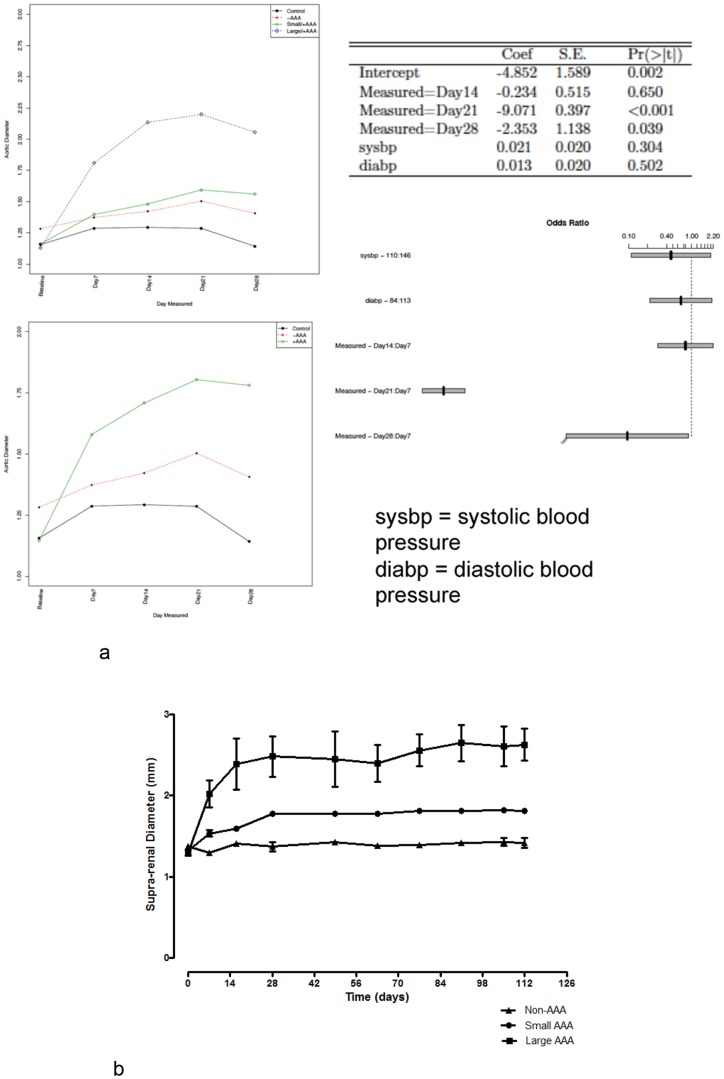
Pattern of AAA development(A) Consistent Temporal Pattern of AAA Development. Temporal evolution of AAA demonstrating the earlier occurrence of large aneurysms in contradistinction to the later development of small aneurysms in mice that underwent continuous 4-week infusion of Ang II (n = 85). The size phenotype appears to be defined at the outset of AAA development, thus suggesting differential susceptibility to Ang II-induced AAA development in genetically homogenous mice. (B): No Quantitative AAA regression Following Cessation of Angiotensin. Continued in vivo US surveillance of a subgroup of mice (n = 10) for 90 days post Ang II infusion did not reveal any evidence of quantitative change in the size of either small or large AAA.